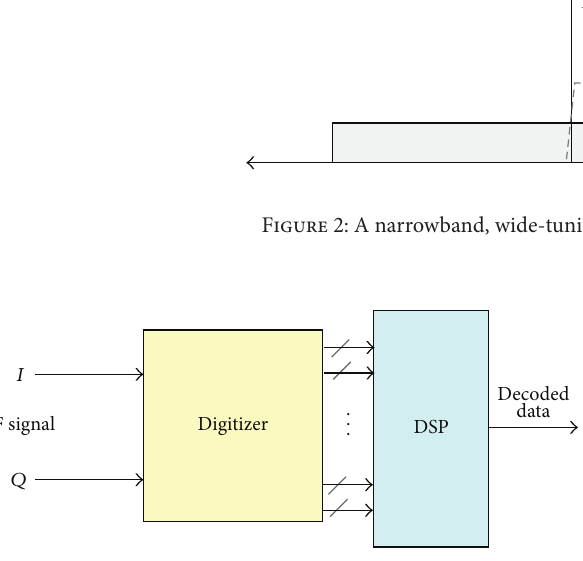
Figure 3: A wideband RF to digital conversion architecture for spectrum